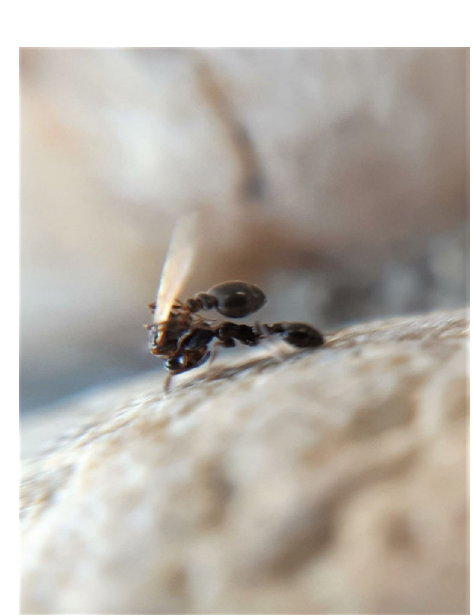
Fig. 1 Gyne carrying in the ant Cardiocondyla elegans . The inserts and the main picture show workers of the ant Cardiocondyla elegans carrying winged female sexuals (gynes) to the nest entrance of another colony to allow outbreeding (photo by M.